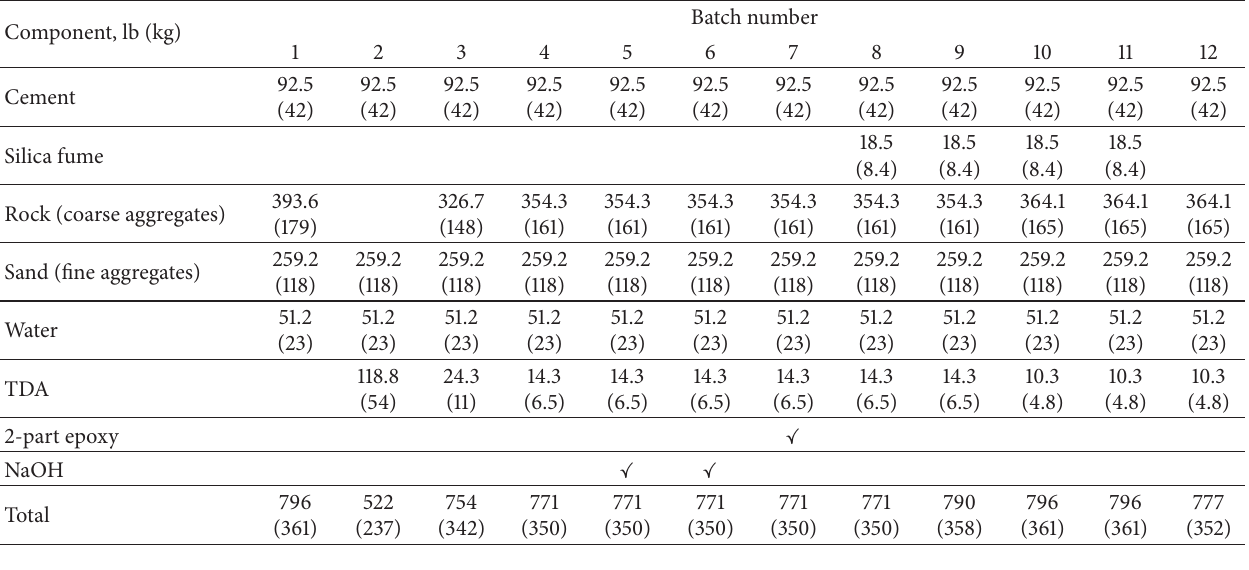
Table 1: Mix proportions for various concrete batches prepared for testing compressive strength to determine amount of TDA to be used.